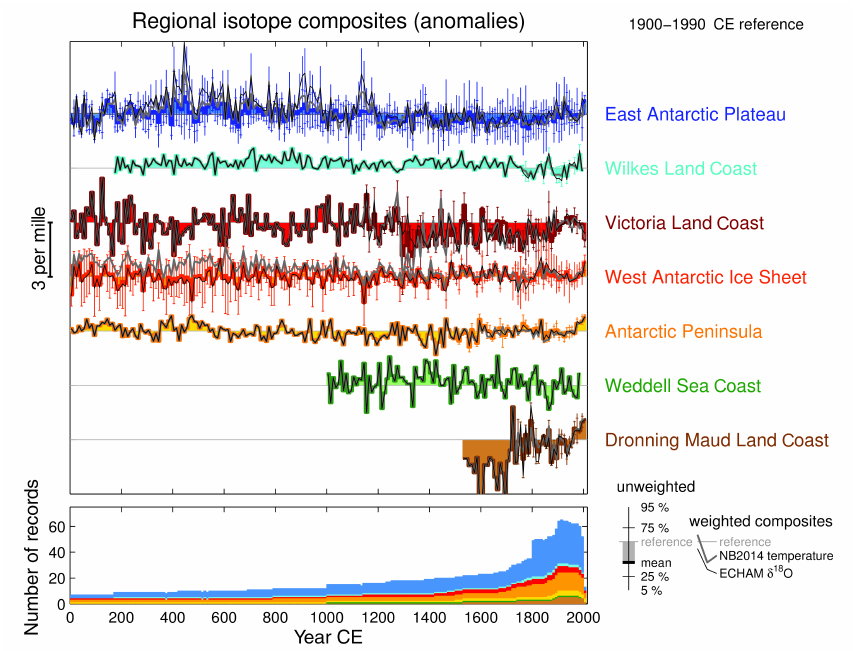
Figure 3. Regional δ 18 O composite reconstructions over the last 2000 years using 10-year-binned anomaly data. Both unweighted compos- ites and weighted composites (using both NB2014 temperature and ECHAM δ 18 O weighting methods) are shown. For each 10-year bin of the unweighted data, the mean δ 18 O anomaly across all records in the climatic region, as well as the distribution of δ 18 O anomalies within each bin, is calculated. All anomalies are expressed relative to the 1900–1990CE interval. The number of records that contribute to the reconstructions for each region are displayed in the lower